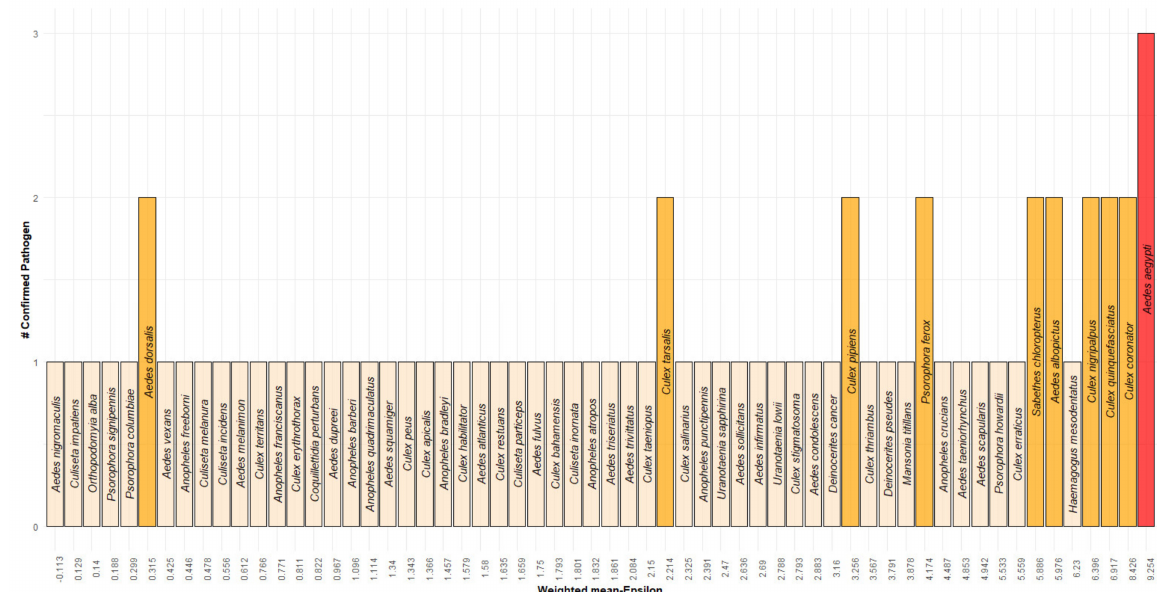
Figure 1. List of vectors ranked by weighted mean ε . X-axis: Weighted mean ε . Y-axis: Number of confirmed pathogens per